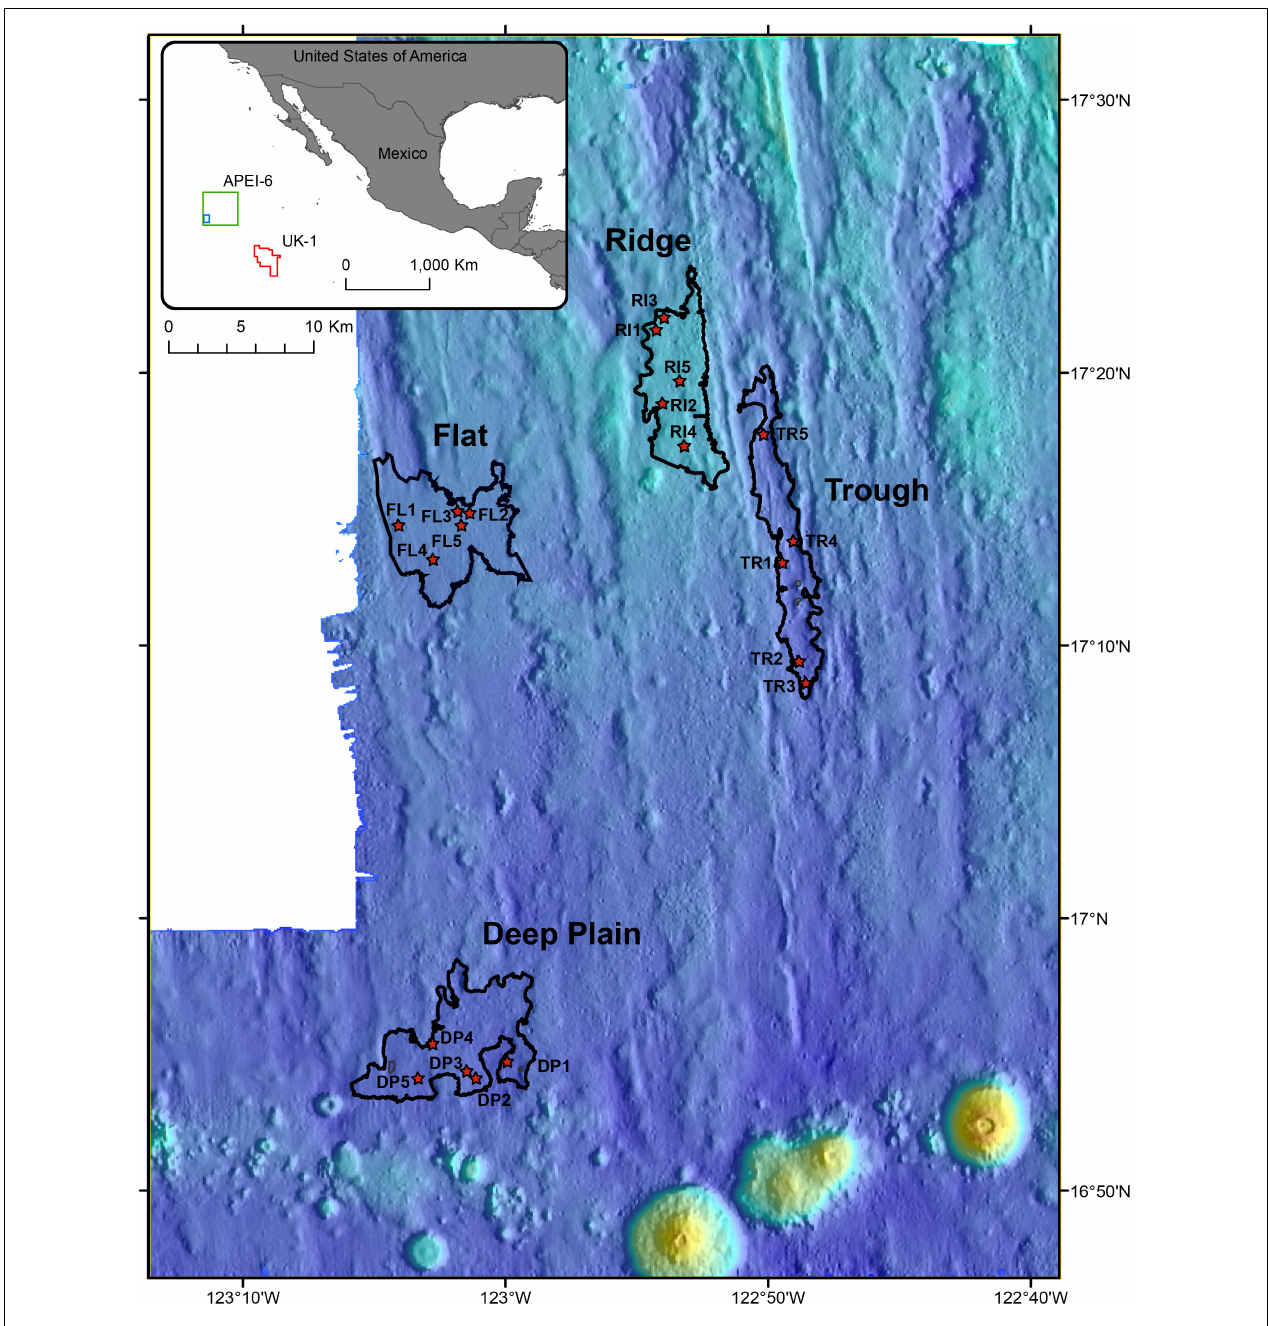
FIGURE 1 | Location of the Area of Particular Environmental Interest (APEI-6) and UK-1 exploration contract area in the Clarion-Clipperton Zone (CCZ) of the Pacific Ocean, where sampling occurred (insert map). Coring locations within the four landscape regions of the APEI-6 are shown with a red star. Red polygon shows location of UK-1, the green box indicates the location of APEI-6, and the blue box delineates the location of the sampling sites within